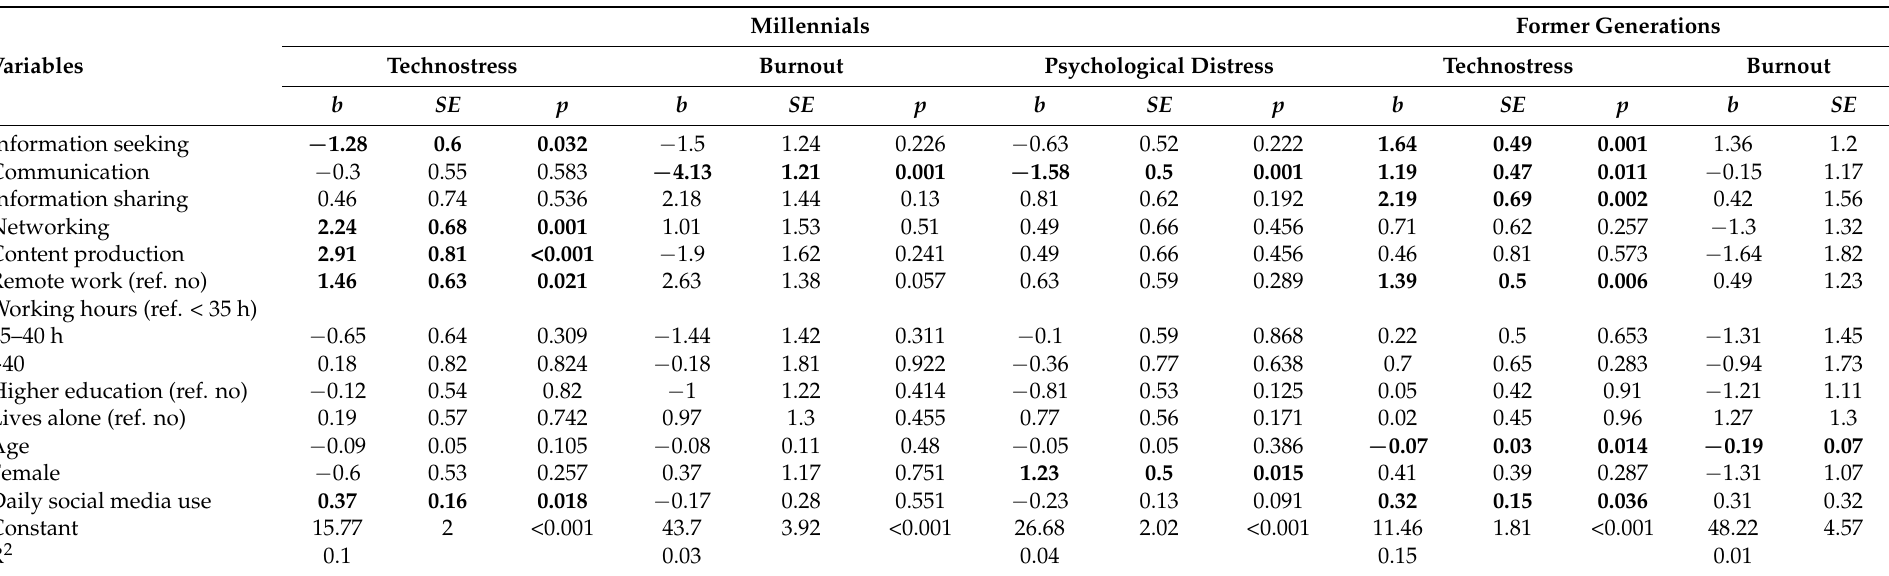
Table 5. Linear regressions on associations of social media use motivations on psychological well-being among Finnish workers ( N =